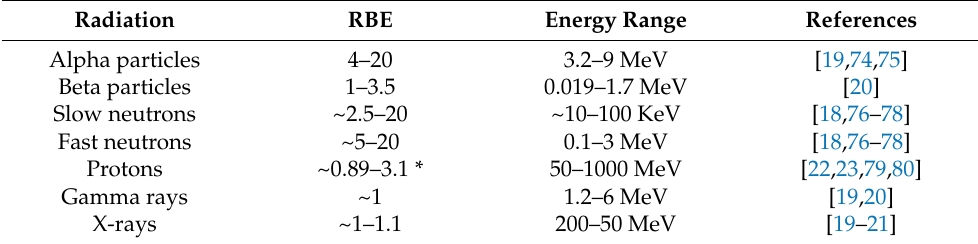
Table 1. Relative biological effectiveness of different types of